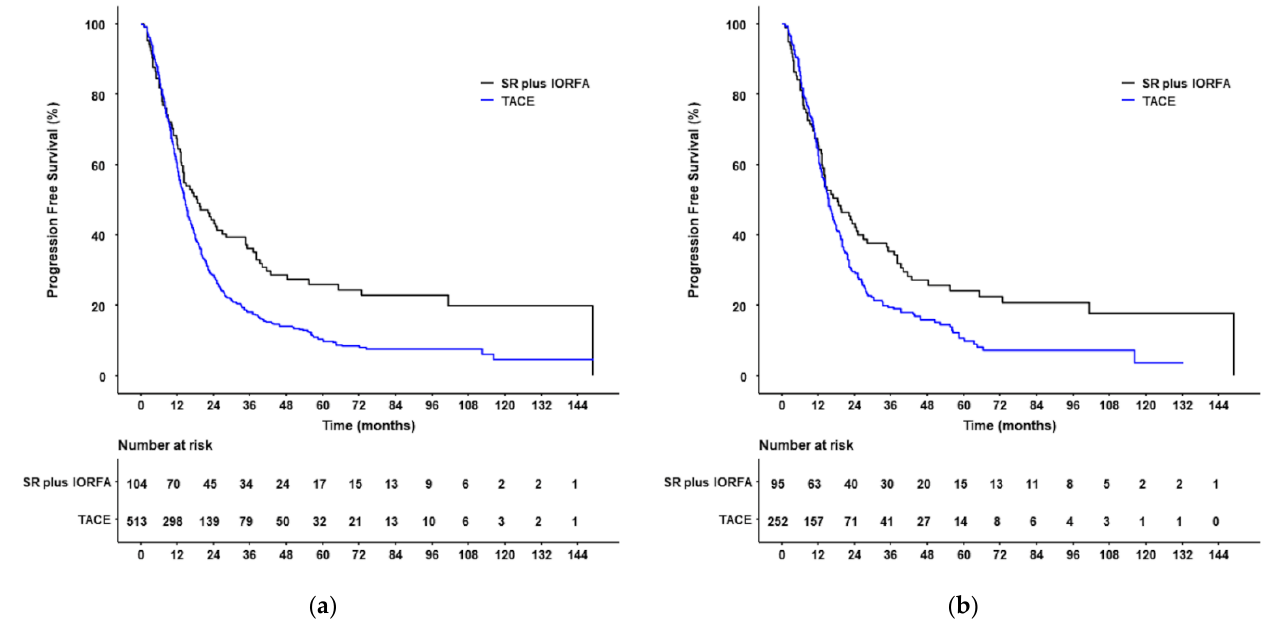
Figure 4. Kaplan–Meier analyses of progression-free survival (PFS) in patients who underwent SR plus IORFA or TACE before ( a ) and after ( b ) PSM. ( a , b ) PFS rates were significantly higher in patients who underwent SR plus IORFA group than in those who underwent TACE both ( a ) before PSM (HR: 0.67 (95% CI, 0.52–0.85), p < 0.001) and ( b ) after PSM (HR: 0.72 (95% CI, 0.54–0.96), p = 0.023).